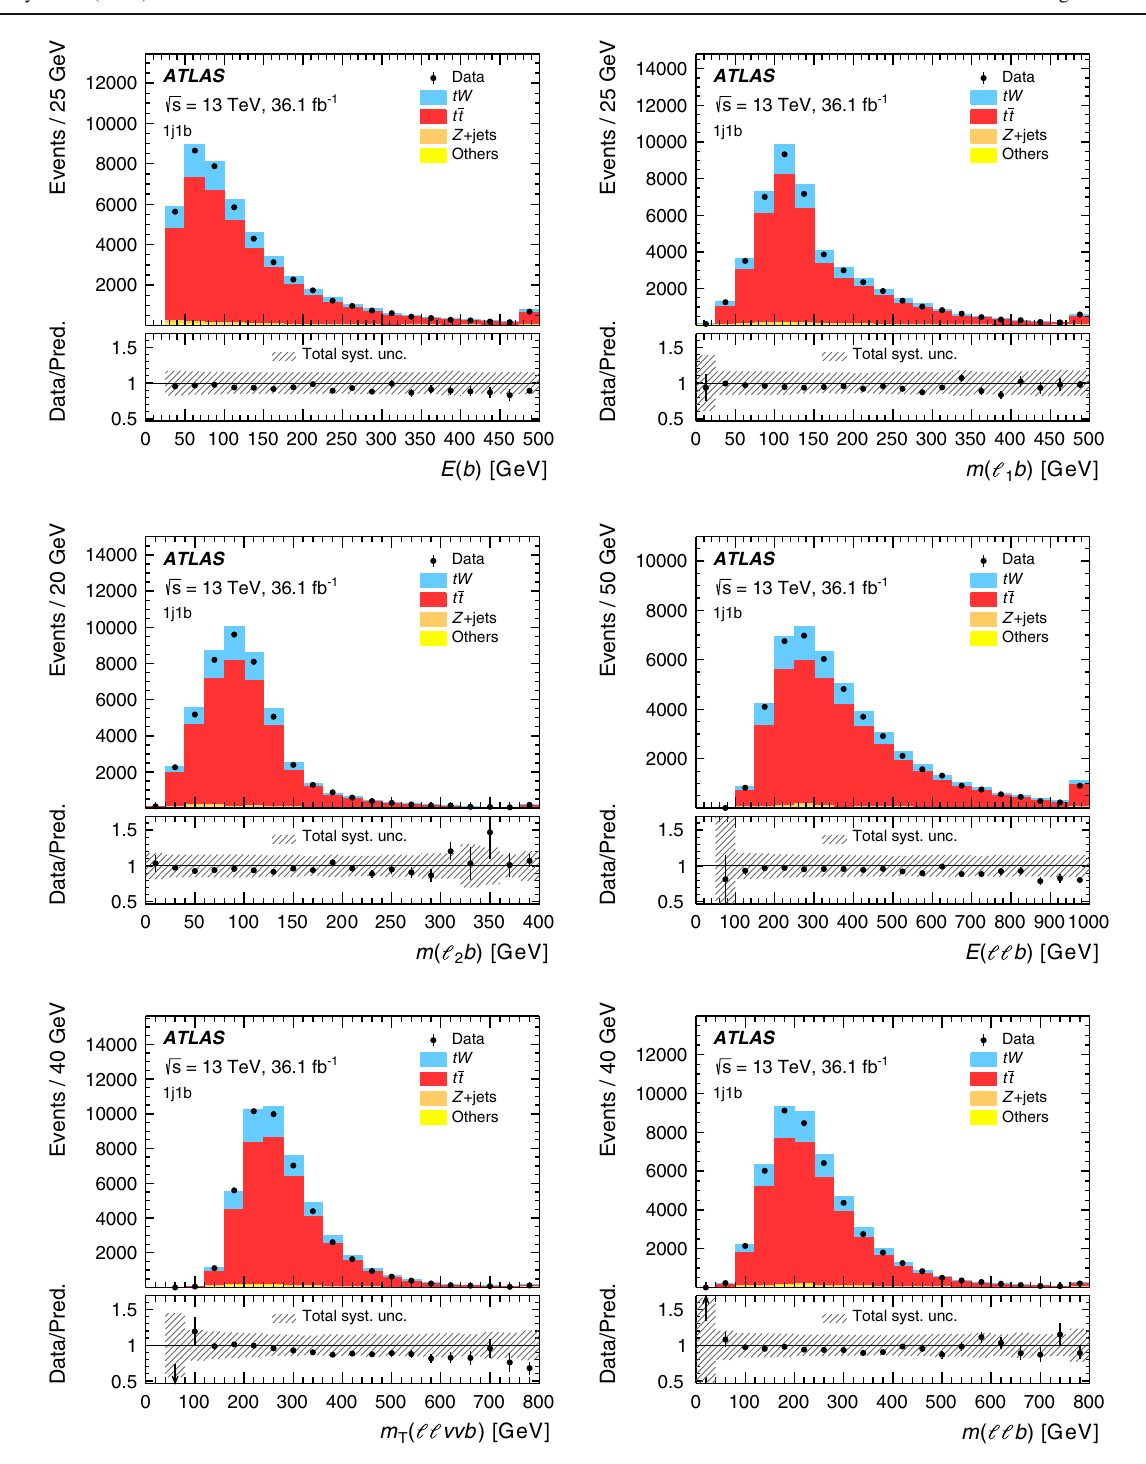
Fig. 3 Distributions of the observables chosen to be unfolded after selection at the reconstruction level but before applying the BDT selec- tion. The signal and backgrounds are normalised to their theoretical predictions, and the error bands represent the total systematic uncer- lation; η( o 1 · · · o n ) is the pseudorapidity of vector sums of various subsets; m ( o 1 · · · o n ) is the invariant mass of vari- ous subsets. For vector sums of two systems of objects s 1